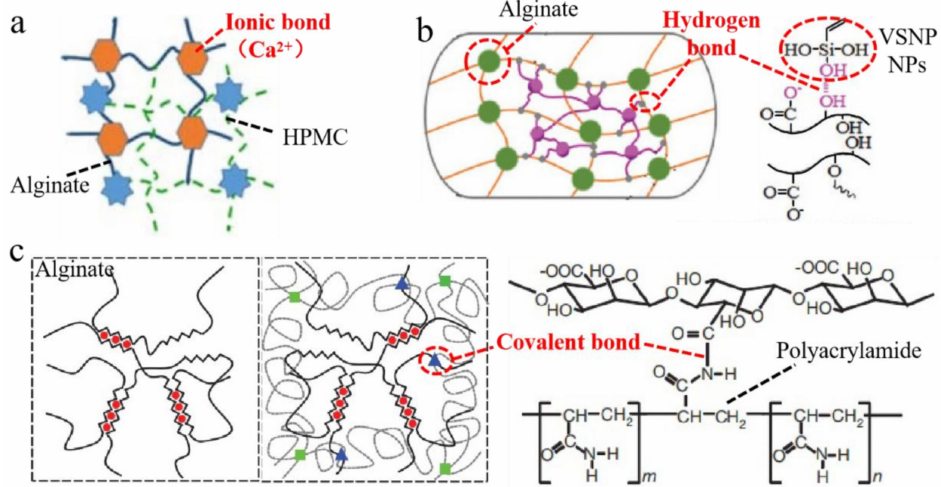
Figure 10. Introduction of ( a ) ionic bond, ( b ) hydrogen bond and ( c ) covalent bond in the alginate